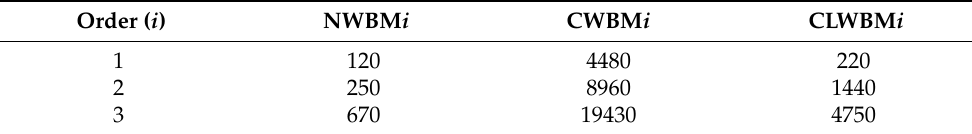
Table 19. Test 5.1. Computational cost (milliseconds) for the mesh with 100 cells. t = 5 s. Order ( i ) NWBM